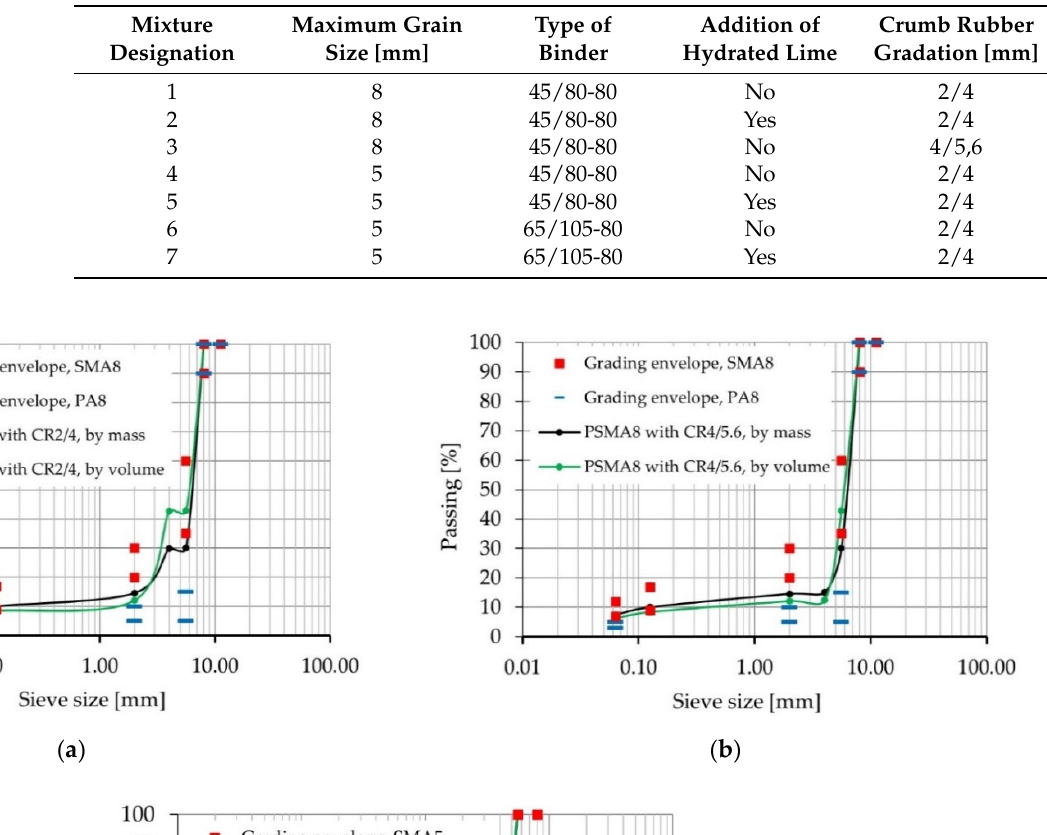
Table 1. Summary of different poroelastic mixtures selected for laboratory acoustic tests.